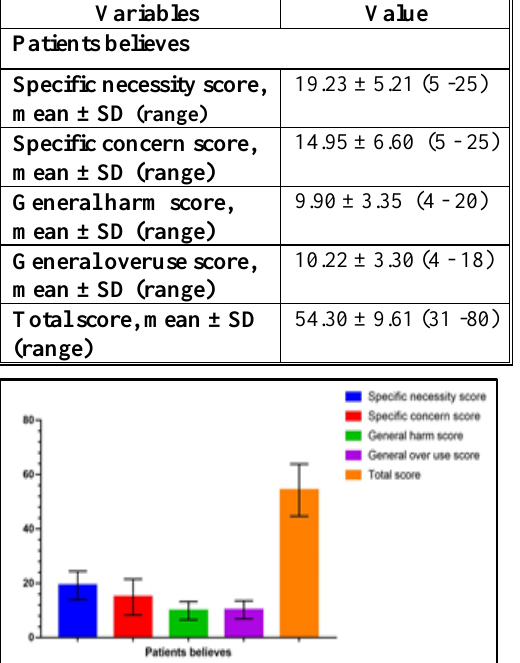
Table 3. Patients believes scores for all